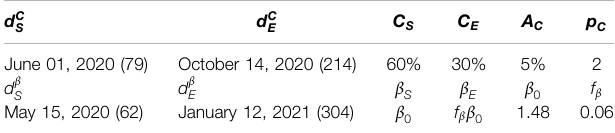
TABLE 2 | Parameter values for con fi nement lifting scheme and social distance measures in Eqs 6 , 7 . β 0 corresponds to the fi tted value up to May 25,